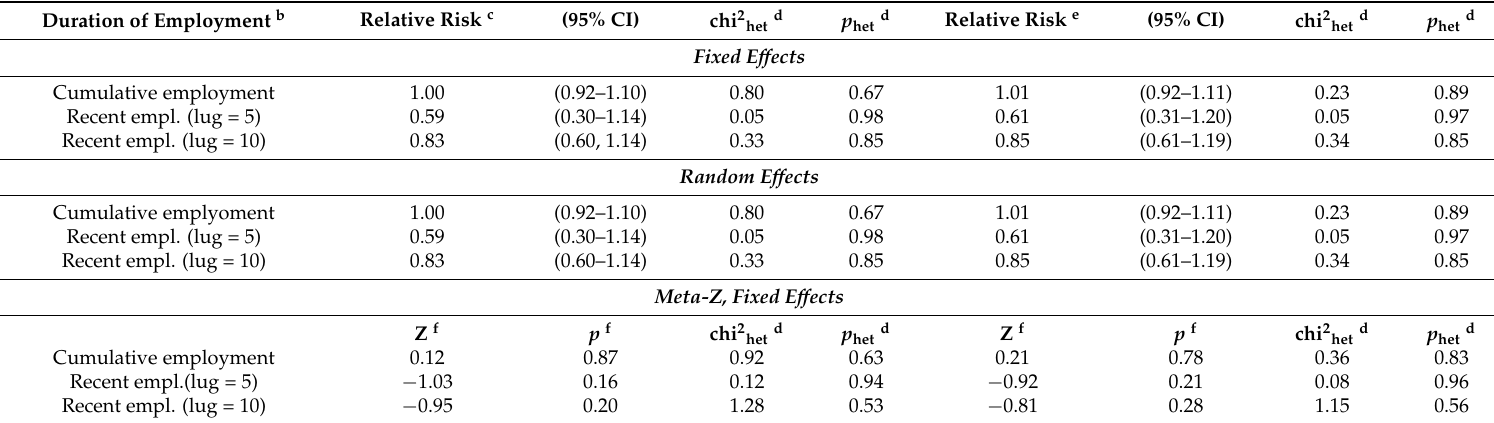
Table 9. Meta relative risk estimates and meta Z -statistics for acute myocardial infarction a obtained from Cox regression (internal analysis) and based on continuous measures of duration of employment in three full cohorts combined (USA, UK, Germany; 432 observed cases).